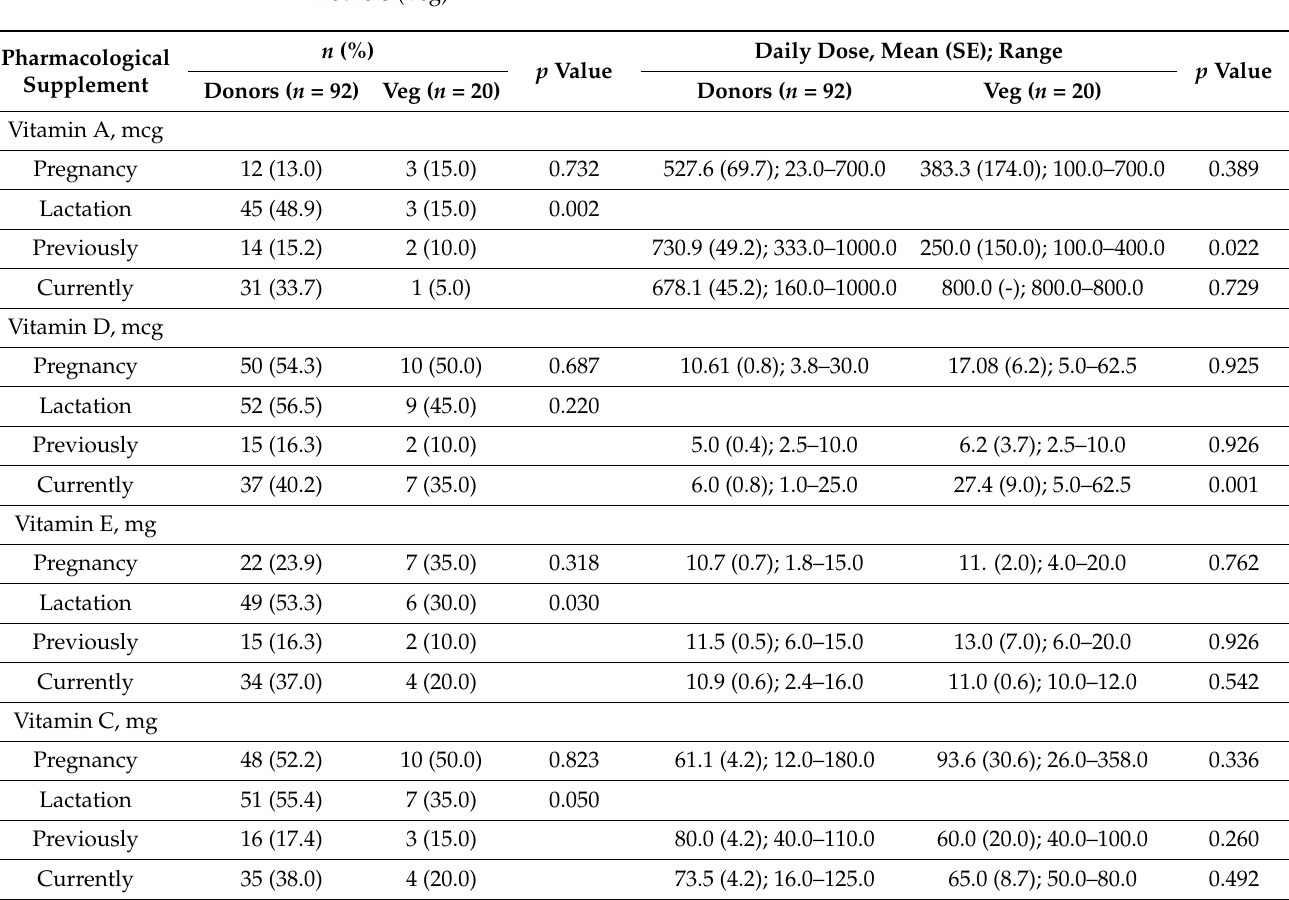
Table 4. Consumption of the pharmacological supplements during pregnancy and the lactation of the omnivore human milk donors with full-term infants (Donors) and vegetarian/vegan lactating mothers